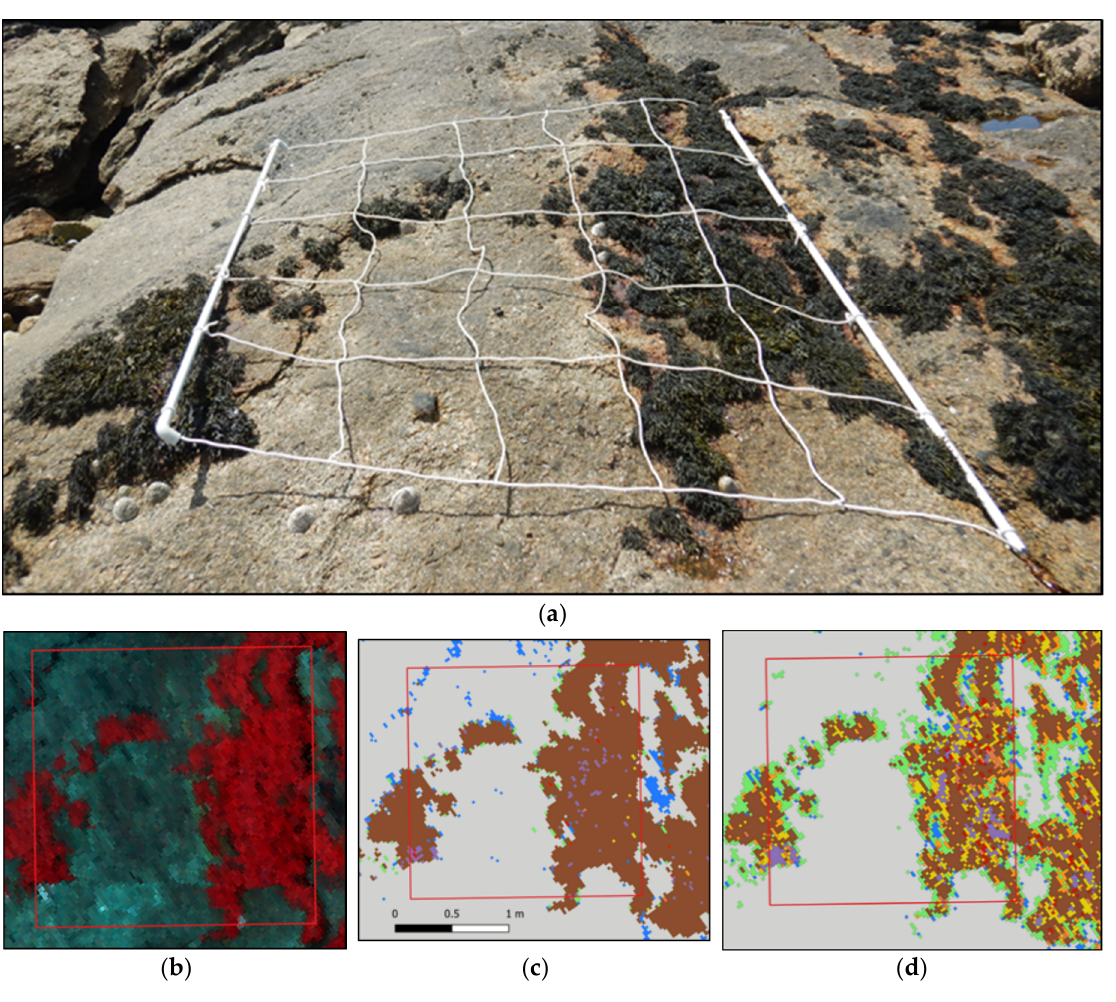
Figure 9. ( a ) Picture of a sampling spot on the Pc-Fspi level at Porspoder taken during field sampling in June 2021. ( b ) NIR-G-B image of the same sampling spot. ( c ) Result of the MLC classification. ( d ) Result of the SAM classification. The red square corresponds to the mobile grid structure used for field sampling. Color code in ( c , d ) corresponds to the following classes: ‘ P. canaliculata ’ (brown), ‘ F. spiralis ’ (yellow), ‘ A. nodosum ’ (purple), ‘ F. serratus ’ (coral), ‘ H. elongata ’ (orange), ‘Red’ algae (red), ‘Green’ algae (green), ‘Substratum’ (grey) and ‘Water’ (blue). To compare covers estimated in situ to those obtained through hyperspectral classification, in situ erect and crustose red algae on one side, and H. elongata and L. digitata on the other side, have been mixed up in order to attain classes similar to remote classification (Figures 10 and 11).